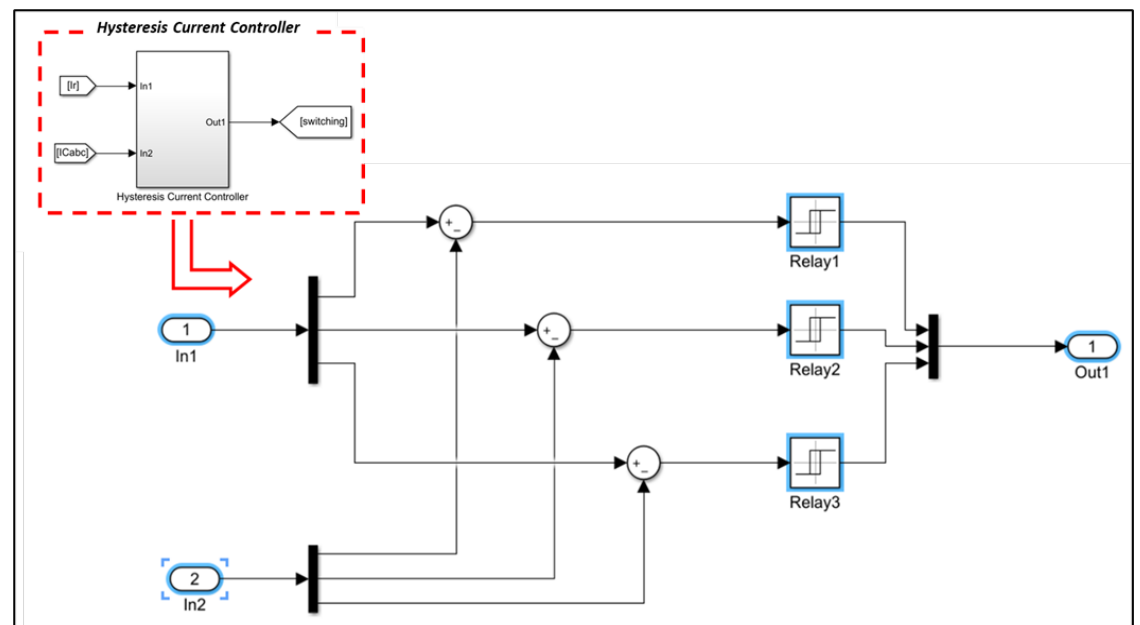
Figure 14. ANN Block and Hysteresis block in Simulink.